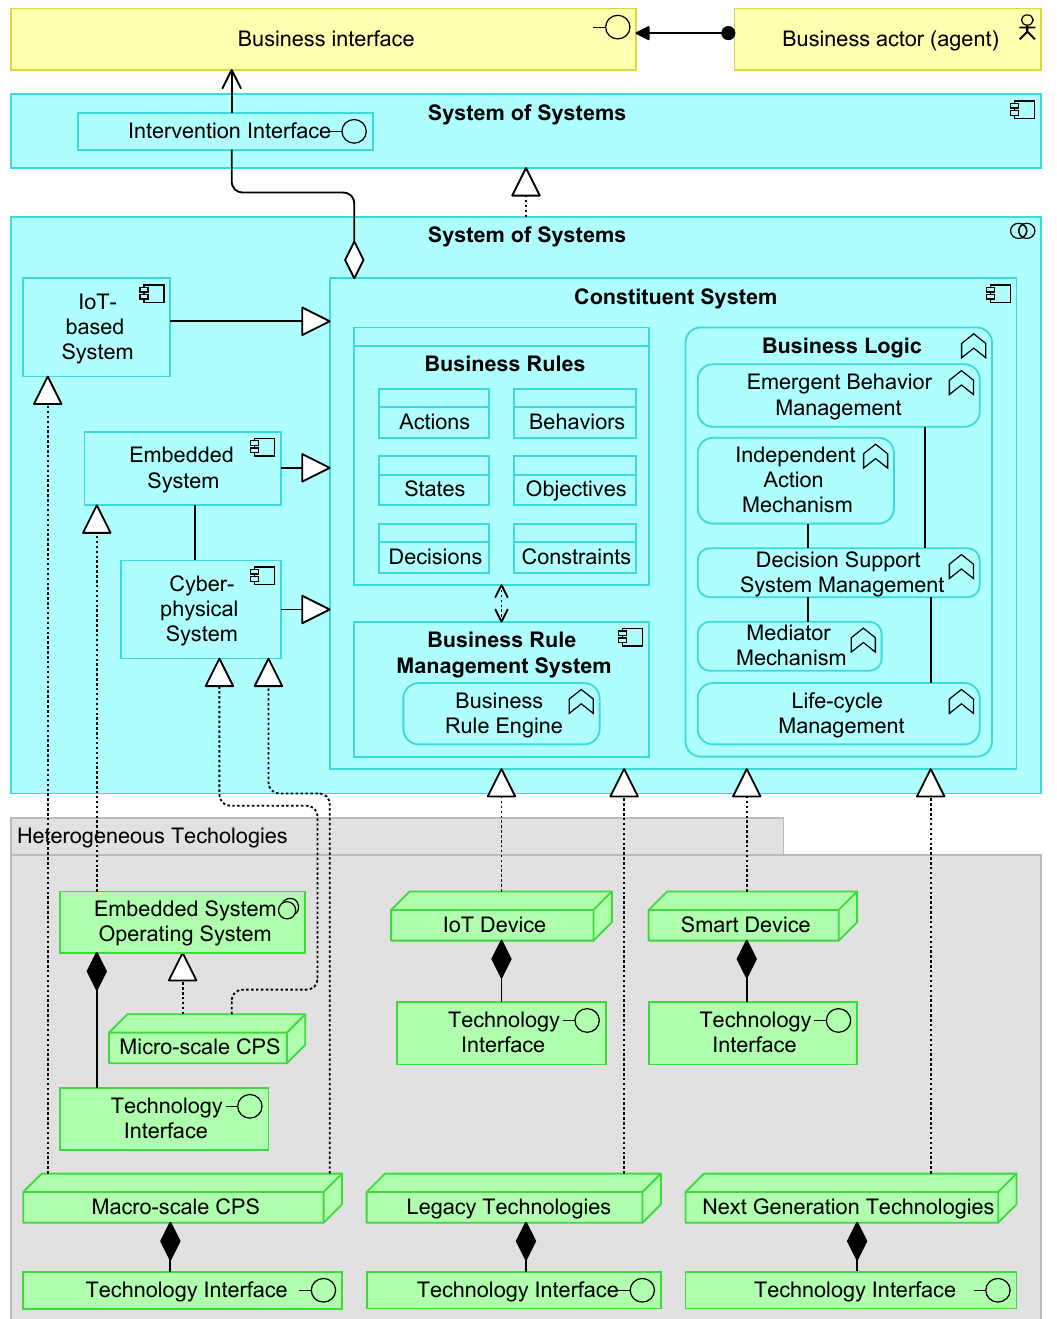
Figure 3. Reference enterprise